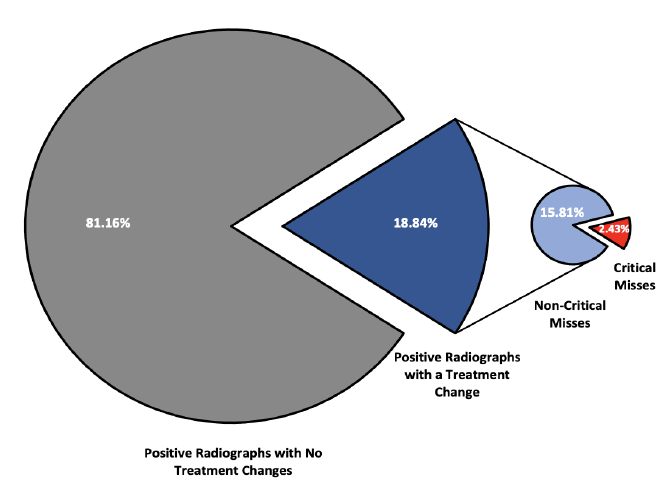
Figure 3. Assessment of the percentage of positive radiographs that experienced a change in treatment recommendation with the addition of oblique radiographs, including patients whose injuries were missed on initial orthogonal two-view radiographs and then went on to be recommended for